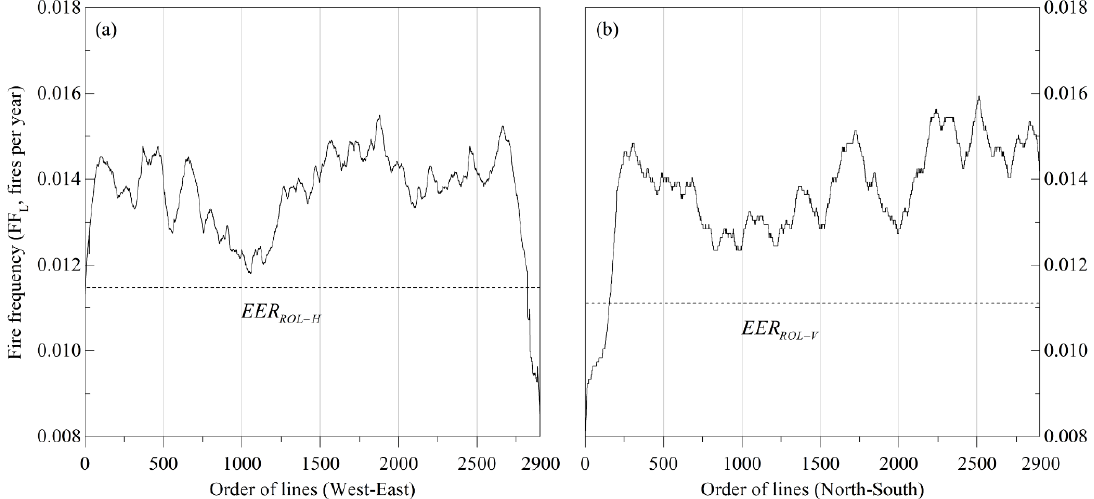
Figure 8. The edge effect region (EER) with reduced fire frequency identified by the agglomeration of inner lines (AIL) method using the grid-level fire frequency map that employed 1200 fire-year maps (GFF 1200 ). Relations are shown between the order in which lines were agglomerated and the population standard deviation of the fire frequency. The color of the vertical line indicates the side of the simulated landscape in which the AIL is located. The dashed line indicates the EER AIL threshold.